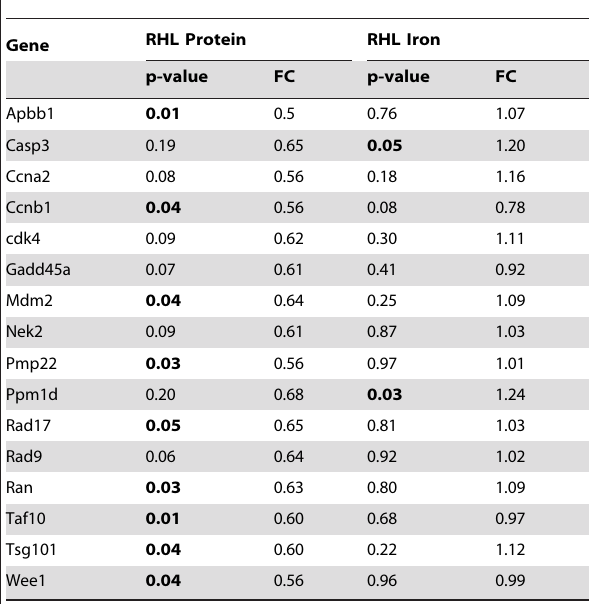
Table 5. Selection of gene expression data from RT 2 Profiler Rat Cell Cycle PCR Array (FC=fold-change, RHL= Rowett Hooded